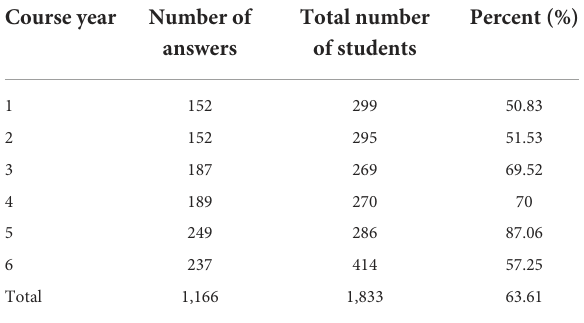
TABLE 1 Number of responses per course